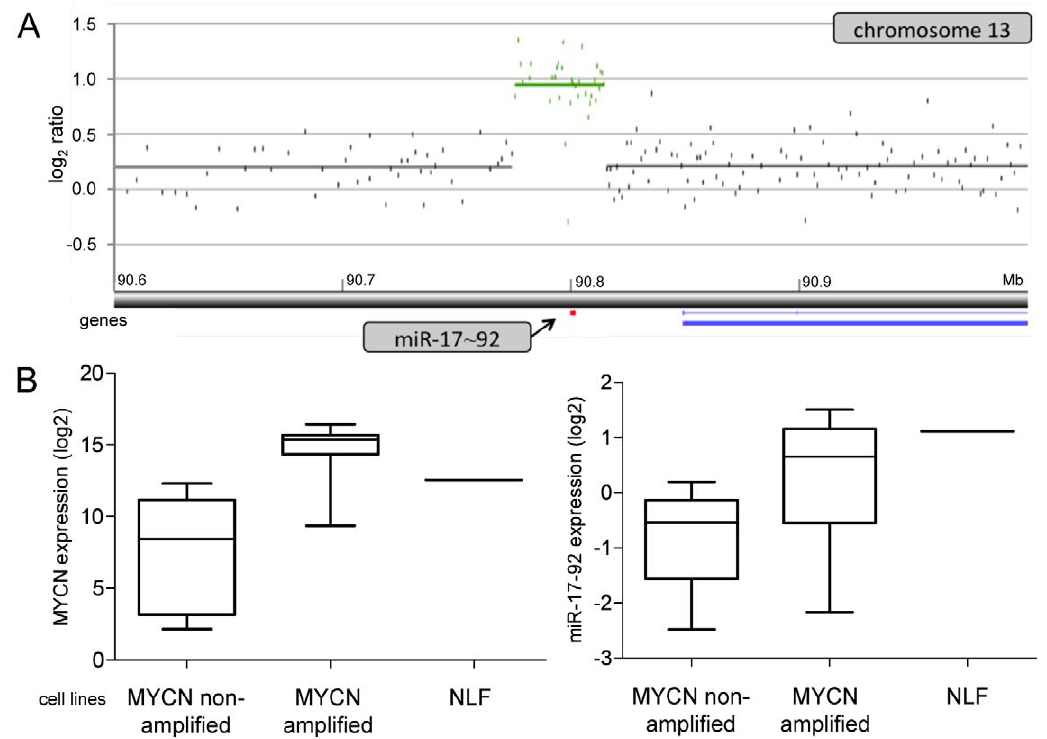
Figure 1. Focal gain of the MYCN activated miR-17 , 92 cluster and expression levels in neuroblastoma cell lines. A. High resolution array CGH analysis shows a 5 kb focal gain for the miR-17 , 92 locus (13q31.3) in the MYCN amplified cell line NLF. B. Expression levels of MYCN (left) and the miR-17 , 92 cluster (right) in 8 MYCN non-amplified and 18 MYCN amplified neuroblastoma cell lines as compared to the MYCN amplified NLF cell line.